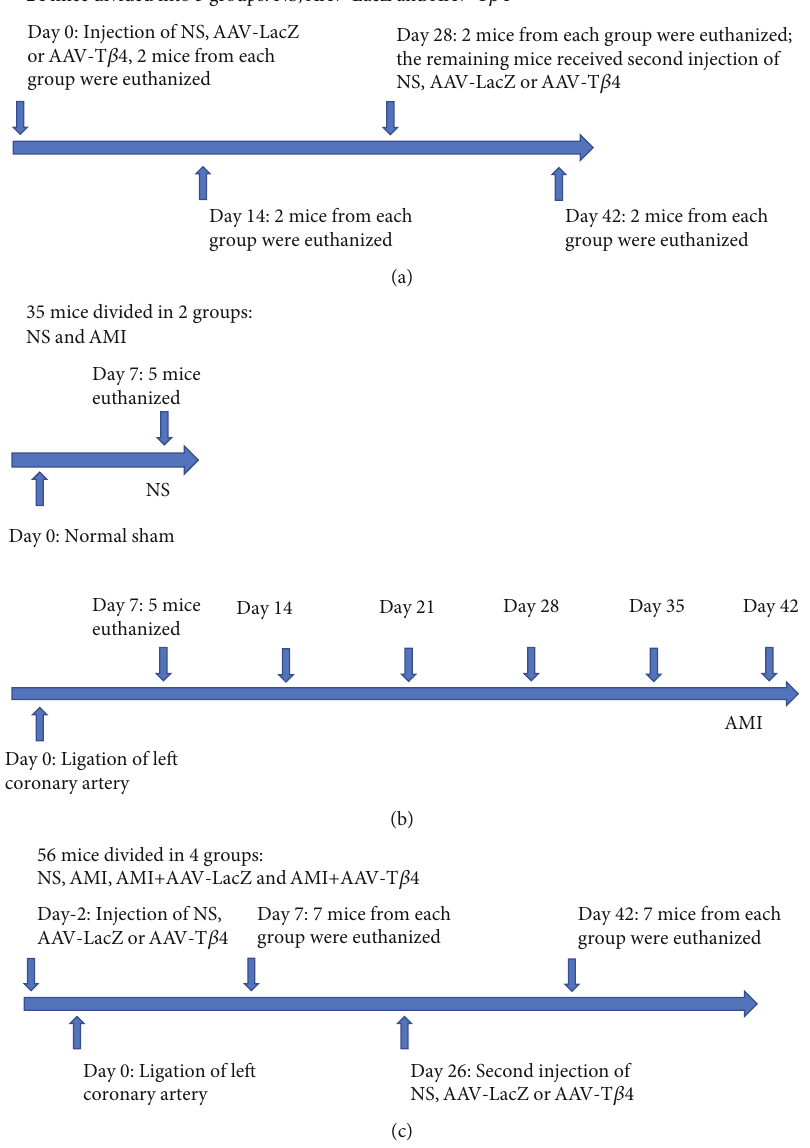
Figure 1: Timeline for the experimental procedures. Procedures for repeated intraperitoneal AAV injections in mice (a). Procedures for ligation-induced AMI mice models (b). Procedures for AAV-T β 4 in AMI